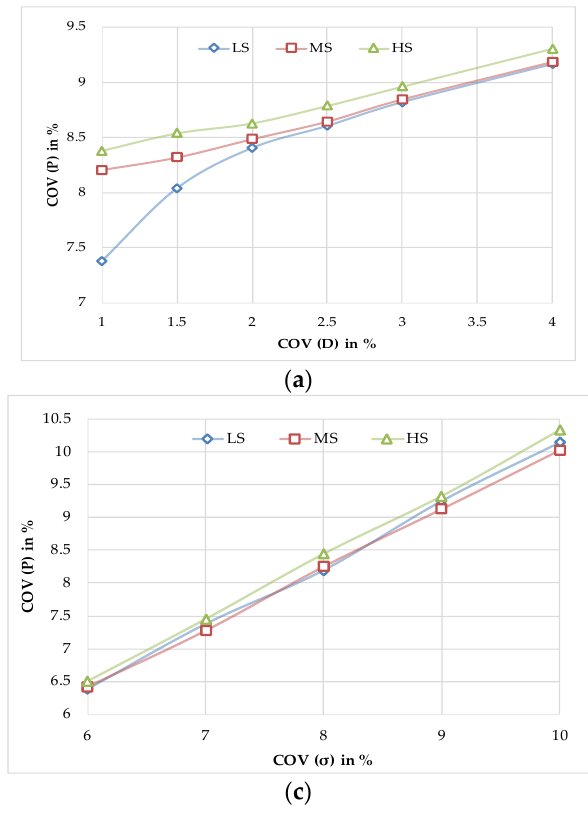
Table 3. Reliability indices ( β ) calculated using 10 top strength models in three steel categories at T o